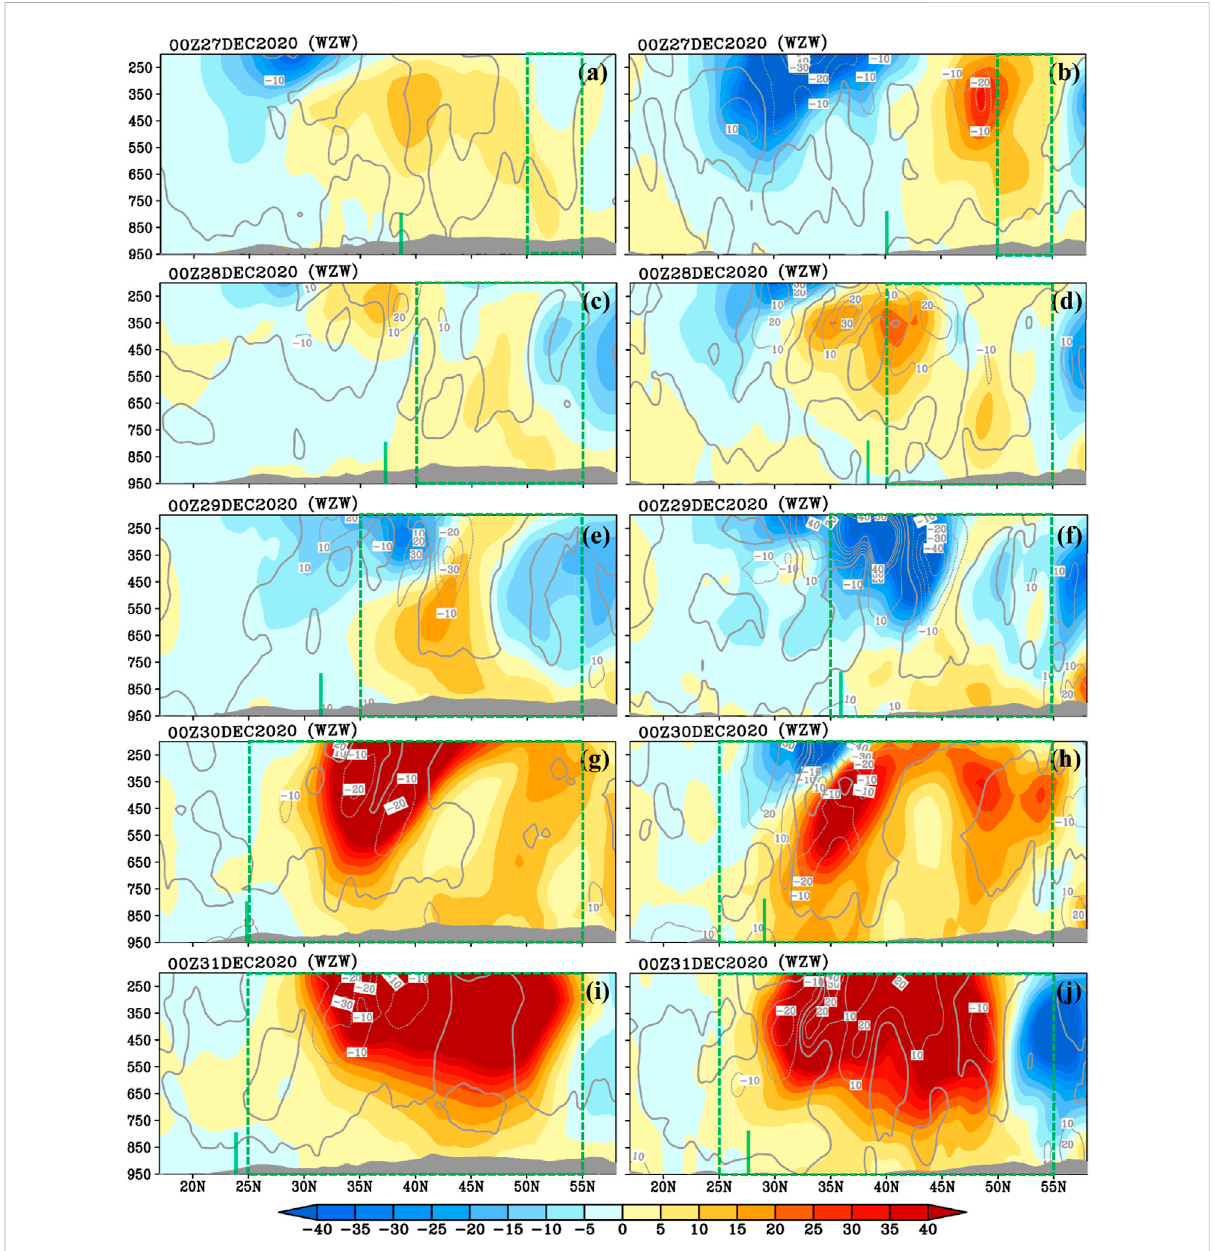
FIGURE 9 (A,C,E,G,I) Zonally (105 – 120 o E; B1) averaged cross=sections of thetermsWZW (work of zonal wind) (shading; 10 − 3 W kg − 1 ), and term TOT (gray contours; 10 − 3 W kg − 1 ). Gray shading at the bottom = terrain. Thick green lines = isotherm of 0 ° C. Green dashed lines = range of the FR1 of the